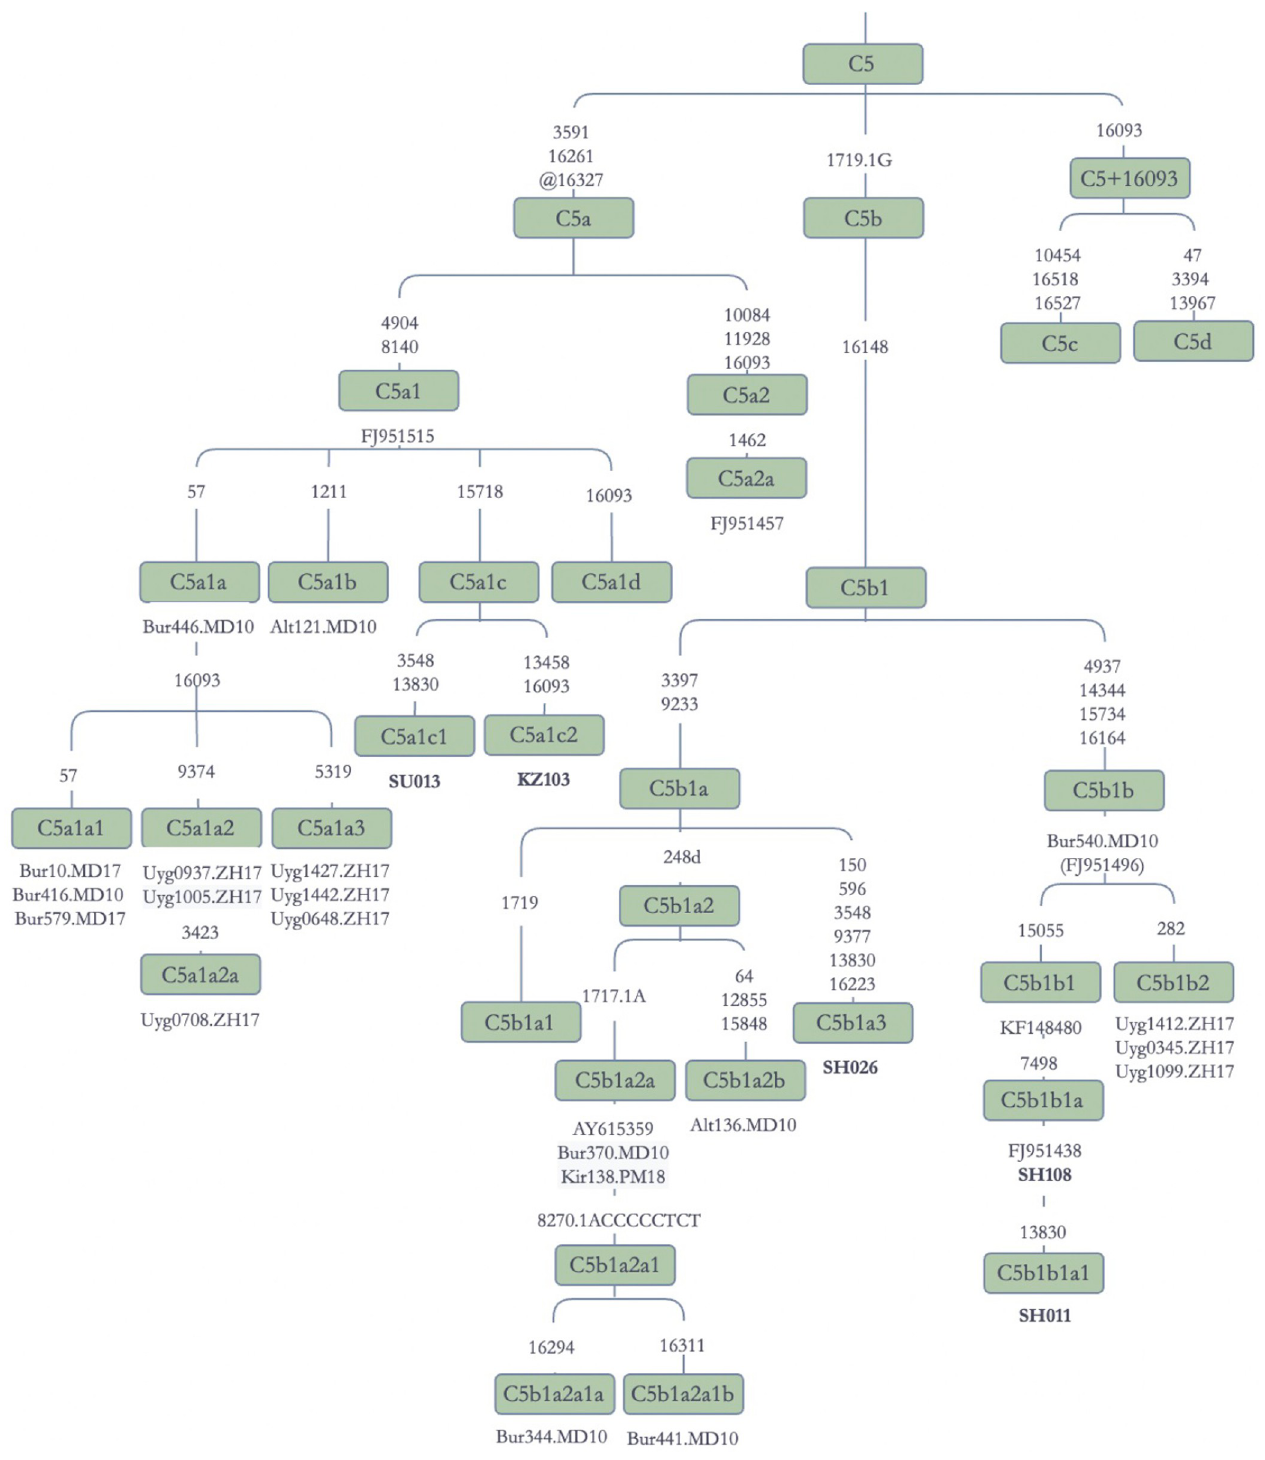
Fig 8. Schematic phylogenetic tree for the haplogroup C5 mitochondrial genomes. Note: Alt: Altaian; Bur: Buryat; Uyg: Uyghur; Kir: Kirghiz.